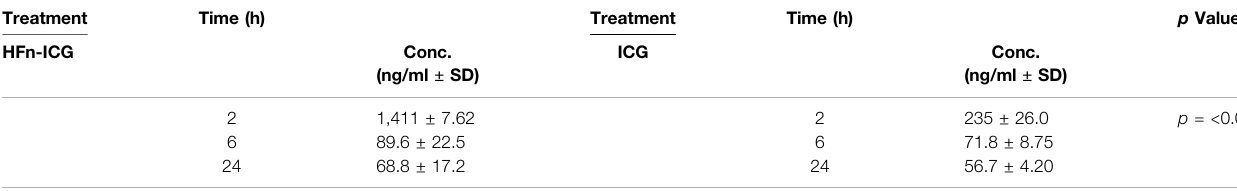
TABLE 4 | HFn-ICG and free ICG concentrations in murine tissue samples.